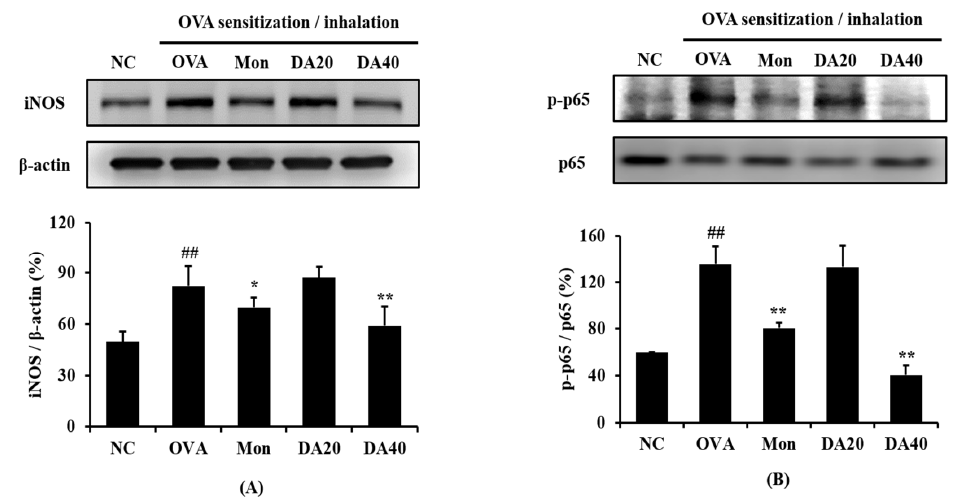
Figure 6. DA inhibited the expression of iNOS and the phosphorylation of NF- κ B in OVA-induced asthma model. Densitometric band value was determined using ChemiDoc (Bio-Rad Laboratories, Hercules, CA, USA). Relative expression value is expressed as iNOS vs. β-actin and p-p65 vs p65. ( A ) Expression of iNOS; ( B ) expression of phosphorylation of NF-κB. Relative expression value NC: normal controls, PBS treatment and inhalation; OVA: PBS treatment with OVA sensitization and inhalation; Mon: montelukast-treated mice (10 mg/kg, oral gavage) with OVA sensitization and inhalation; DA20 and 40: Dipsacus asperoides C. Y. Cheng et T. M. Ai-treated mice (20 and 40 mg/kg, respectively, oral gavage) with OVA sensitization and inhalation. The values shown are the means ± SD. ## p < 0.01 vs. NC; * p < 0.05, ** p < 0.01, respectively.